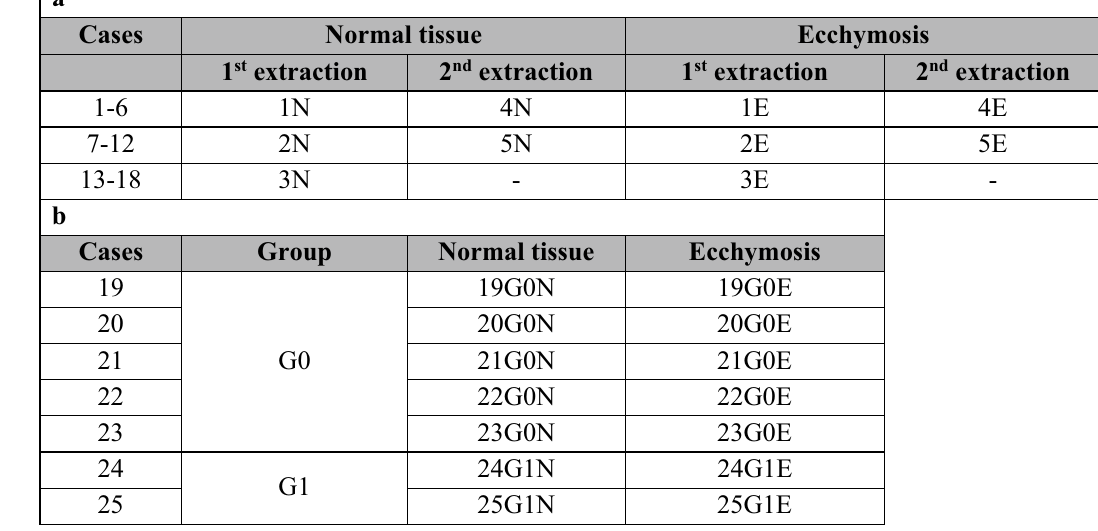
Table 1. Overview of the analyzed samples. For each case, both ecchymosis (E) and adjacent normal tissue (N, control sample) were collected. (a) List of 18 couples of skin samples for cases with unknown wound dating. The ecchymotic and normal full thickness skin samples from 6 cases were pooled as indicated; (b) List of 7 couples of skin samples for cases with known wound dating, grouped in two classes: Group G0 (death within 1 h after trauma) and Group G1 (death within 1–12 h after